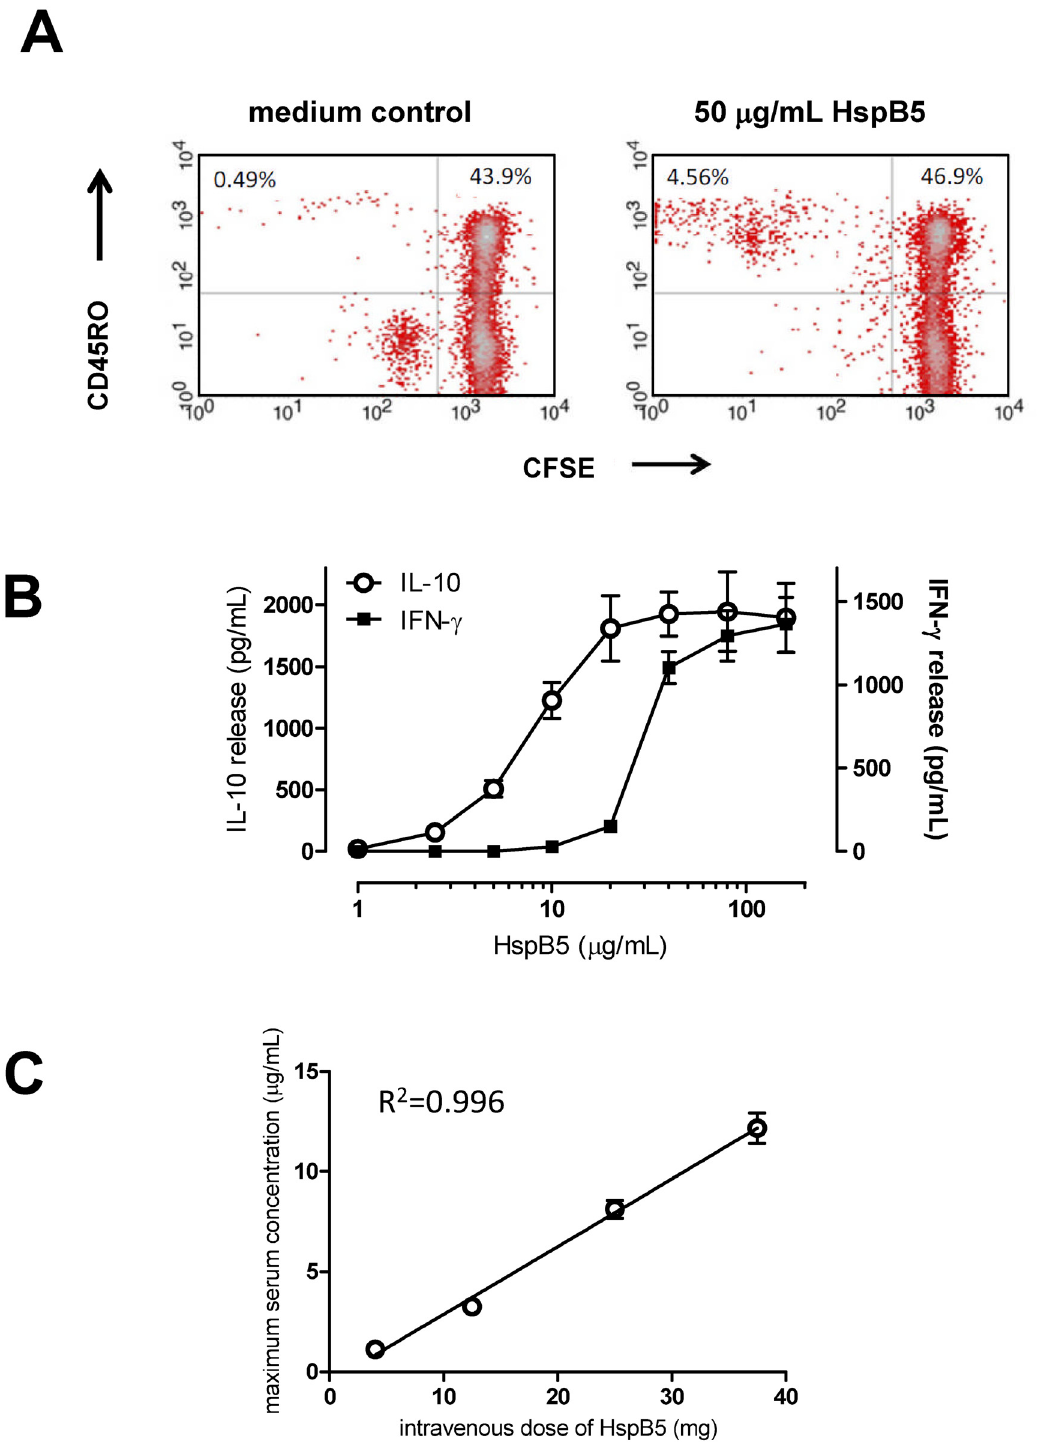
Fig 2. Selection of therapeutic intravenous doses of HspB5 in humans. Therapeutic application of HspB5 in humans relies on activation of M2-like protective microglia and macrophage responses, while avoiding pathogenic IFN- γ responses by memory T cells. In Fig 2A, the existence of a substantial HspB5-reactive memory T-cell repertoire in humans is illustrated by a representative fresh PBMC sample from a healthy subject. Proliferative responses to HspB5 of CD45RO + memory T cells in this sample are reflected by proliferation-induced dilution of the fluorescent tracer CFSE over 9 days in culture. With CFSE dim CD45RO + T cells representing proliferated memory T cells, Fig 1A illustrates that a substantial part of all human memory T cells, an estimated one